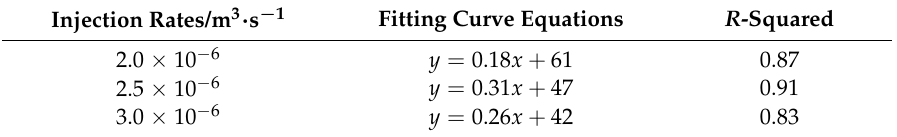
Figure 29. Variation of the total number of cracks with NF density under different injection rates and confining pressure ratio is S H : S h = 10:5. Table 8. Fitting curve equations of the total number of cracks under different injection rates.